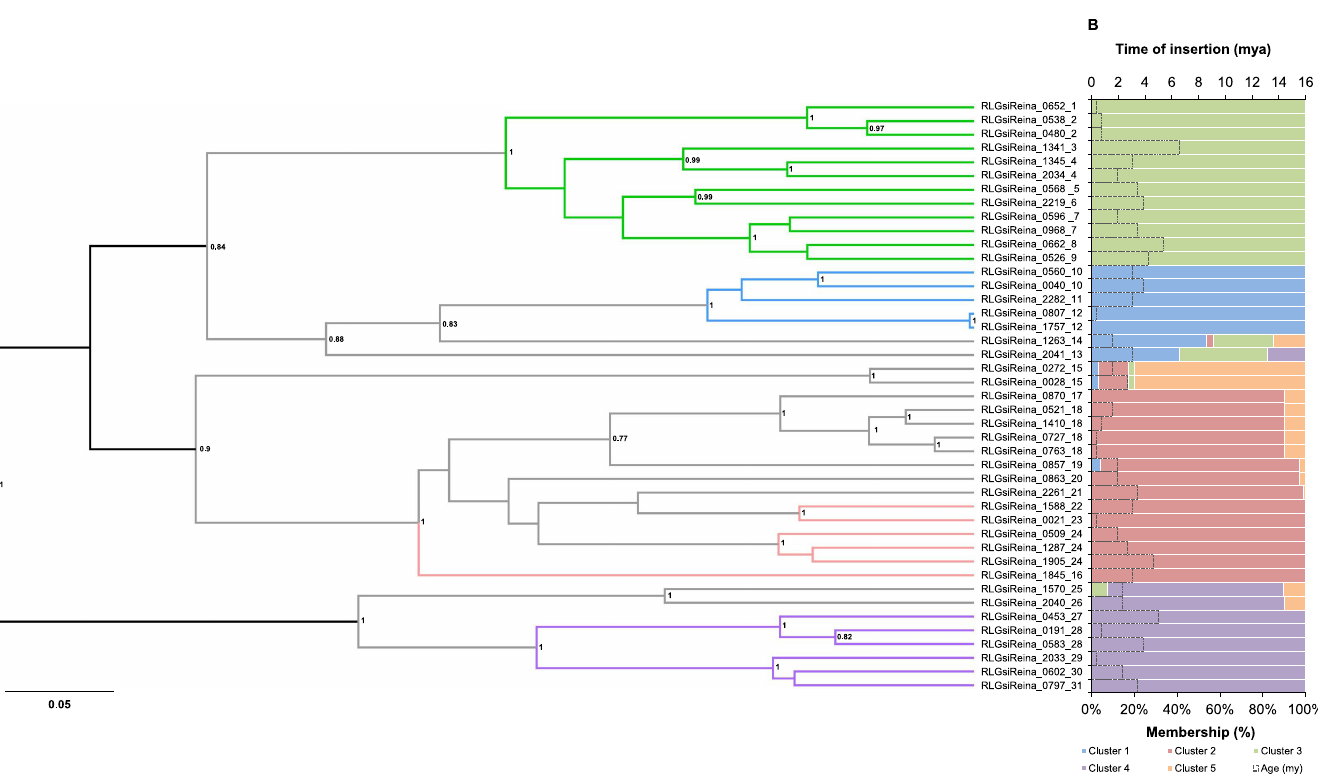
Fig 4. Evolutionary relationships of the Reina lineage elements. (A) Bayesian phylogenetic tree based on RT amino acid sequences. Posterior probability values below 0.7 are not shown. (B) STRUCTURE plot (colored bars, bottom axis) based on RT sequences, showing the percentage of membership of the elements in the clusters and time of insertion (dotted bars, upper axis) based on the LTR sequences ( mya ). In both the tree branches and plots, each color represents a cluster. The numbers at the end of the name of the elements indicate the family. The tree and STRUCTURE plot were based on an amino acid alignment with 176 positions. mya: millions of years ago; my: millions of